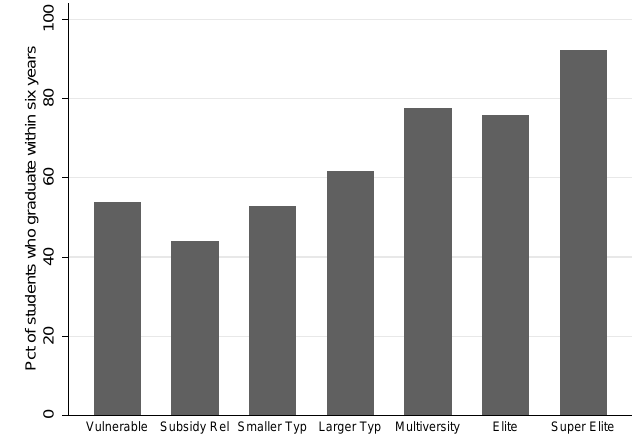
Figure 3. Average six-year graduation rate by institutional